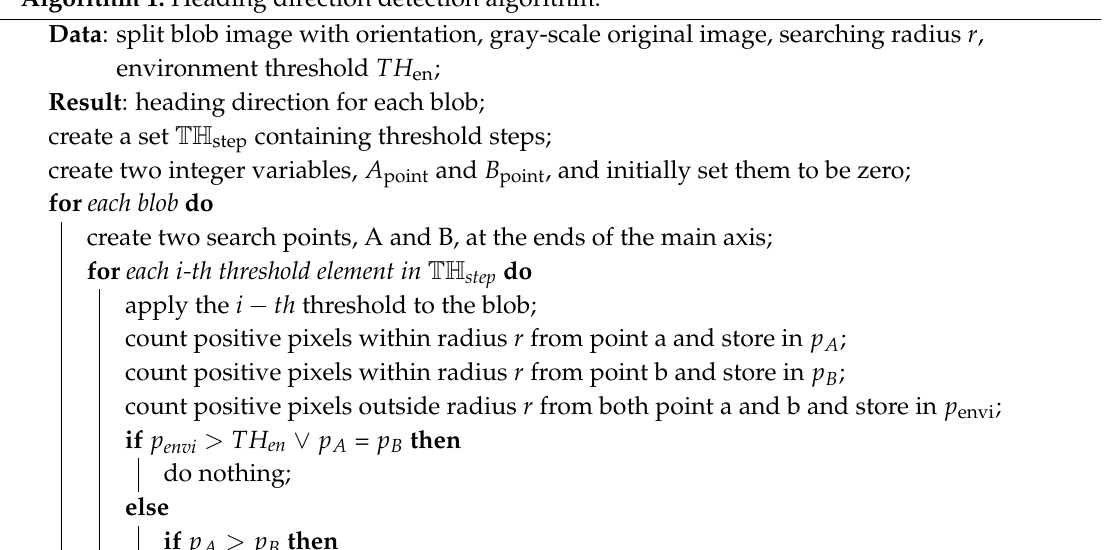
Algorithm 1: Heading direction detection algorithm. Data : split blob image with orientation, gray-scale original image, searching radius r ,